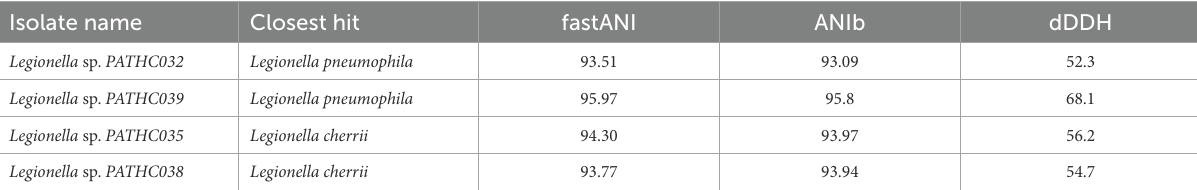
TABLE 3 Summary of in silico novel species proof test for the isolates determined to be new species candidates. Isolate